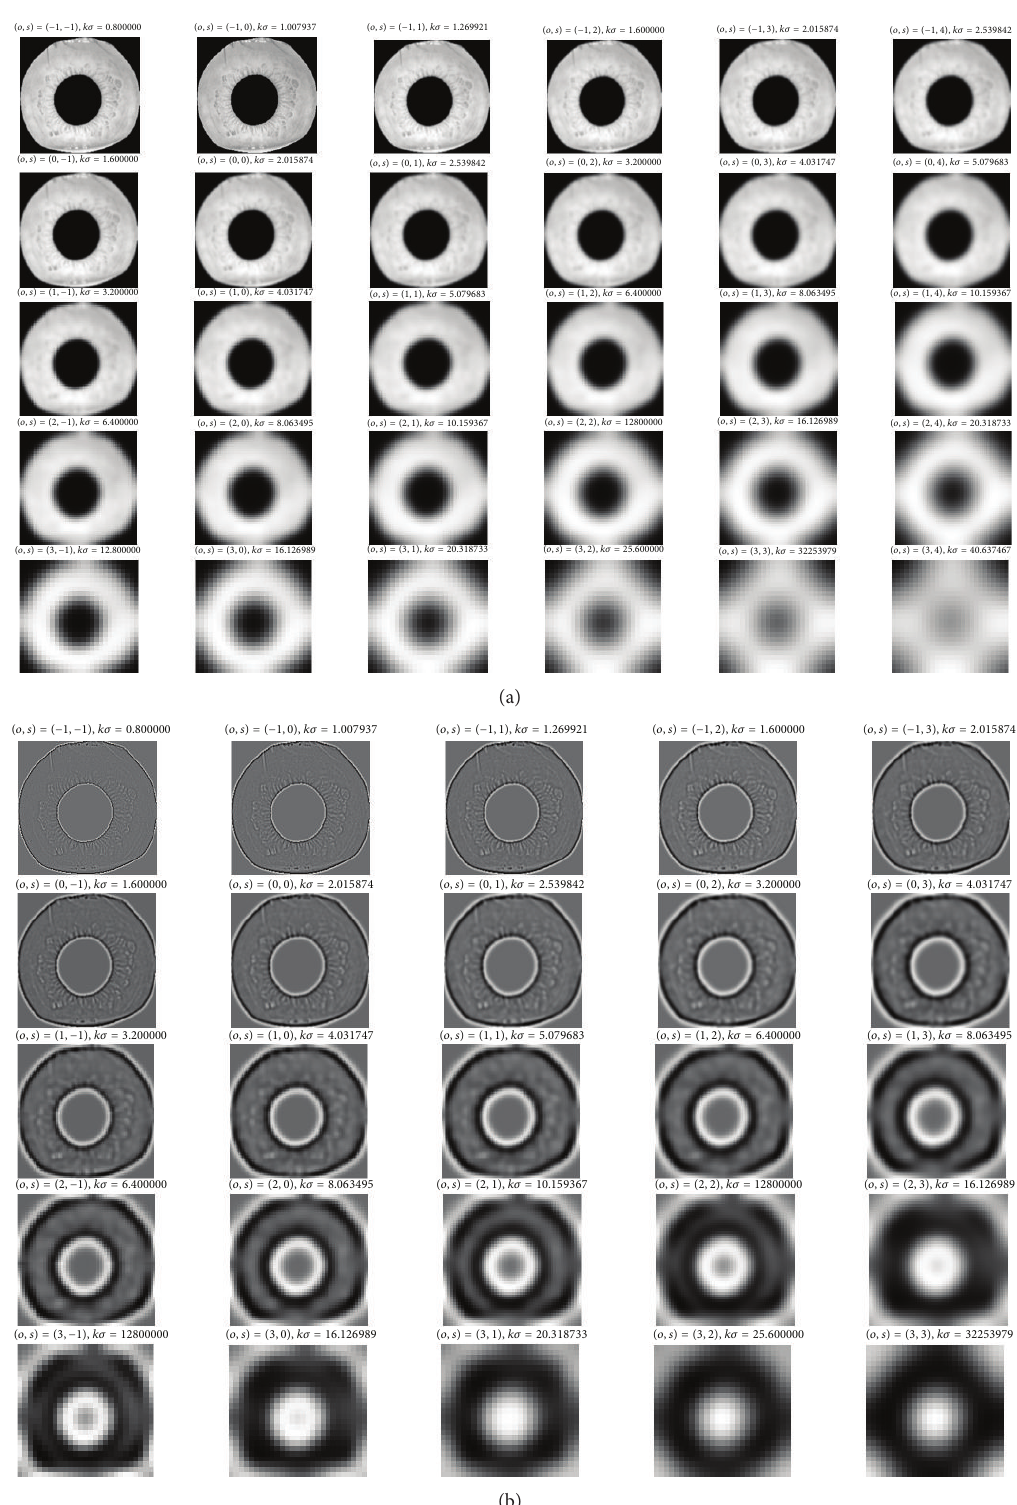
Figure 2: Detection of scale-space extreme. (a) Gaussian smoothed annular iris images for different octave, scale, and 𝜎 ; (b) corresponding DOG